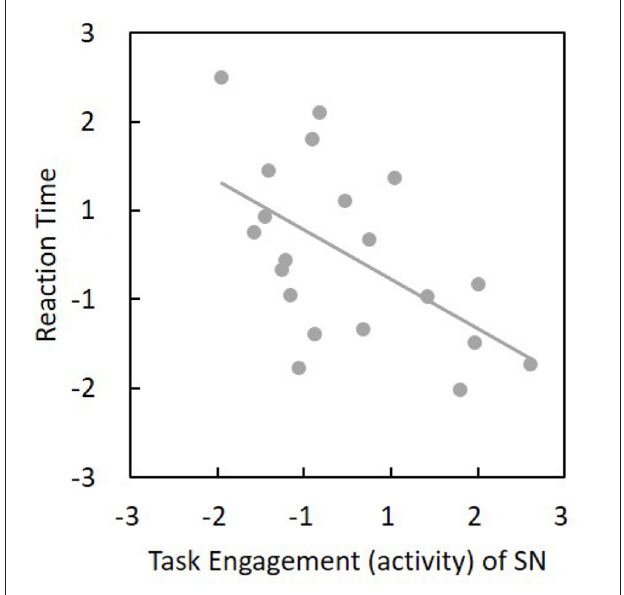
FIGURE 5 | Task engagement (activity) of SN was negatively associated with reaction time ( r ( 18 ) = − 0.55, p = 0.02). The horizontal and vertical values represent standardized z -scores. Thus, a more task-engaged SN would show a faster reaction. SN, salience network.